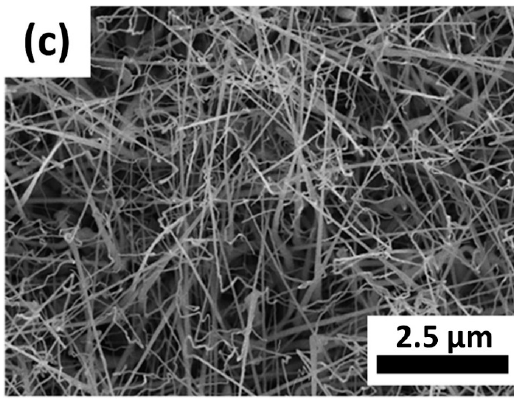
Figure 4. SEM images of nanowires grown at gas flow rates ( a ) 100 sccm and ( b ) 200 sccm at 850 °C. ( c ) SEM image of nanowires grown at 1000 °C for 5 min.